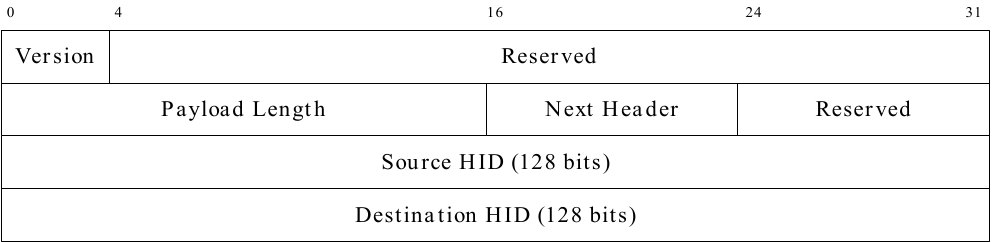
Figure 8. HID format.